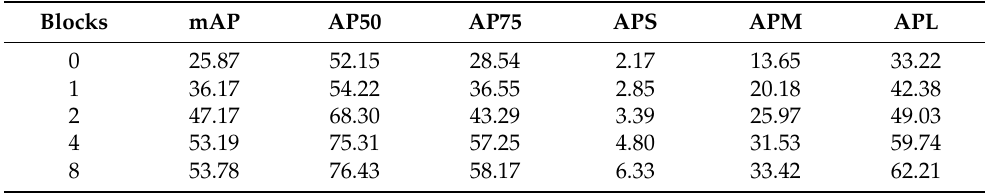
Table 7. Ablation study for the DIOR dataset with the different encoder blocks. Blocks with 8 show a